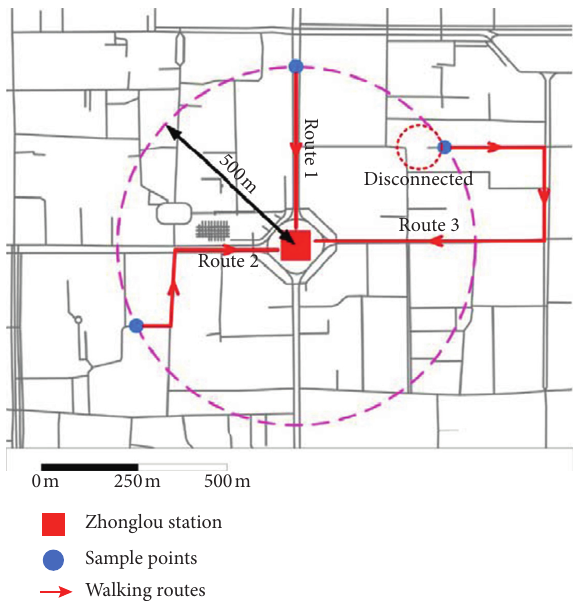
Figure 2: Map of the road network around Zhonglou Station on ML #2 showing three different routes that can be taken to arrive at points that would be considered equidistant from the station based on the Euclidean